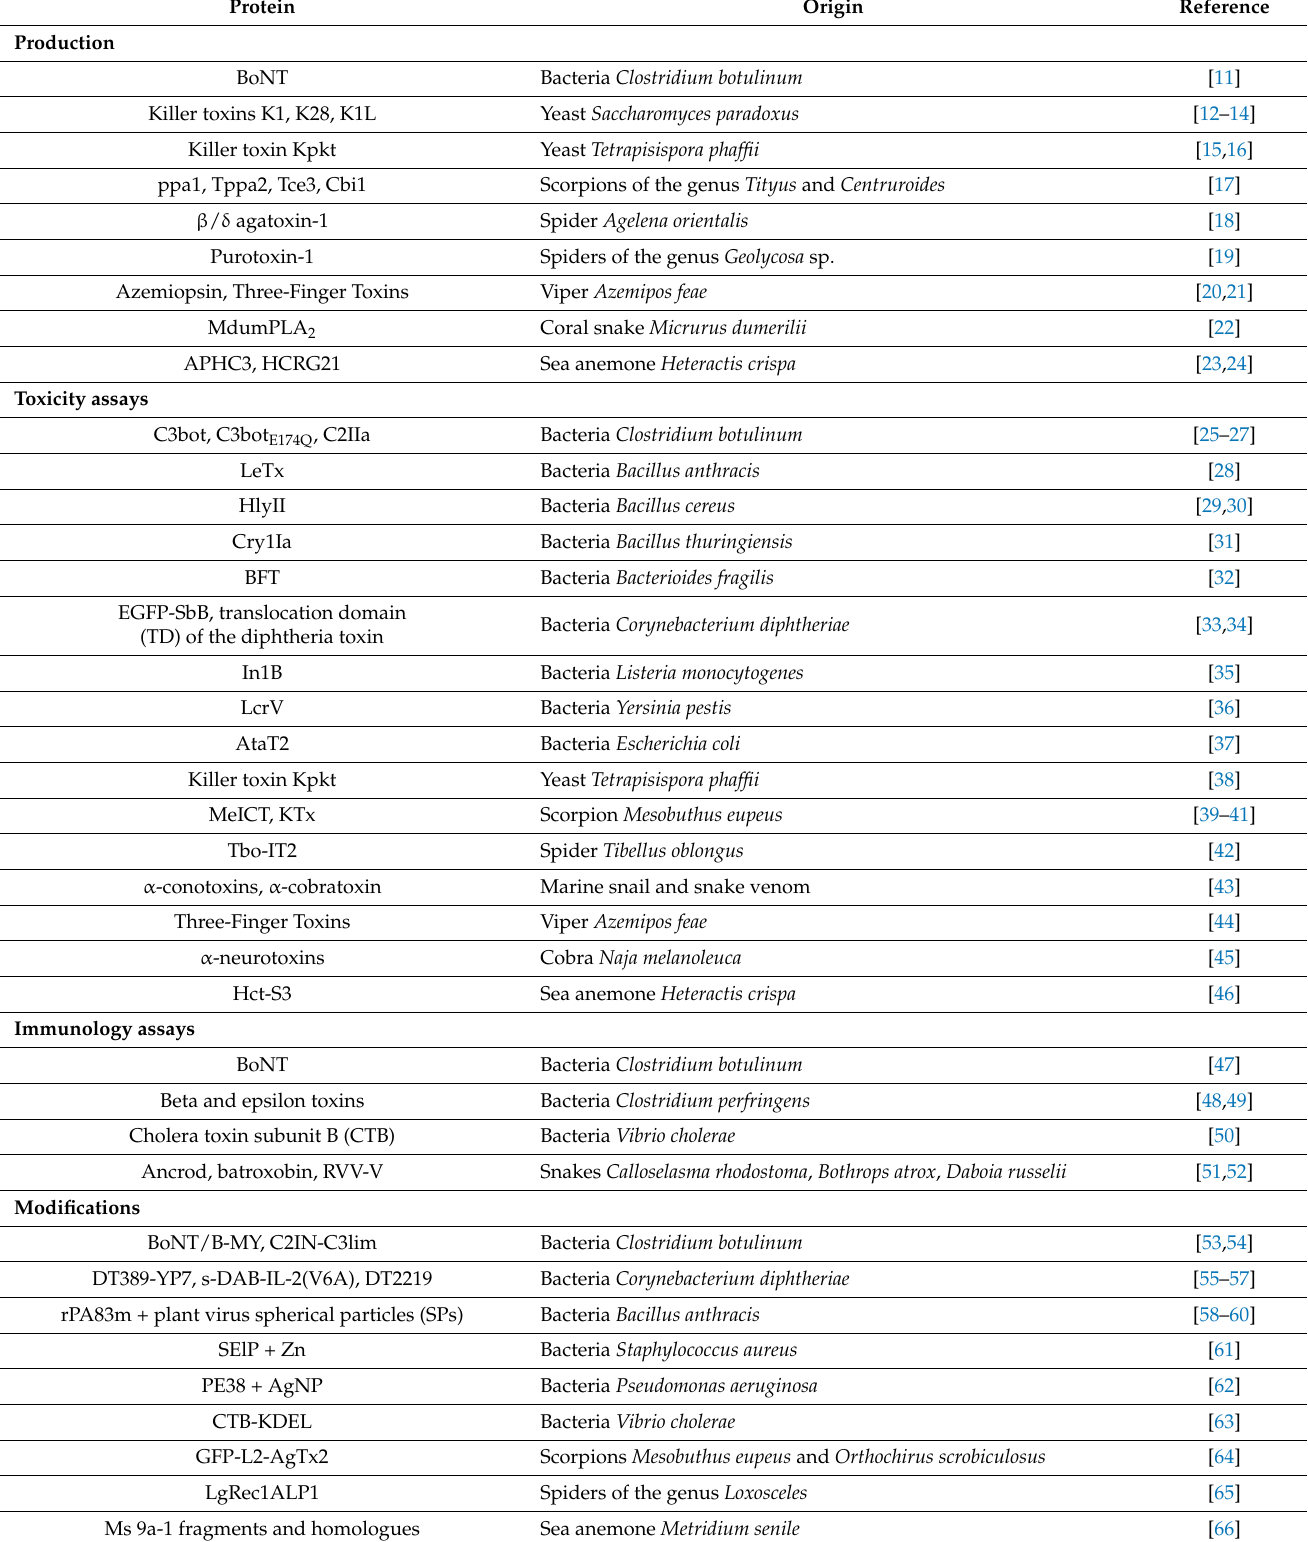
Table 1. Recombinant toxins from various origins and the purposes of their